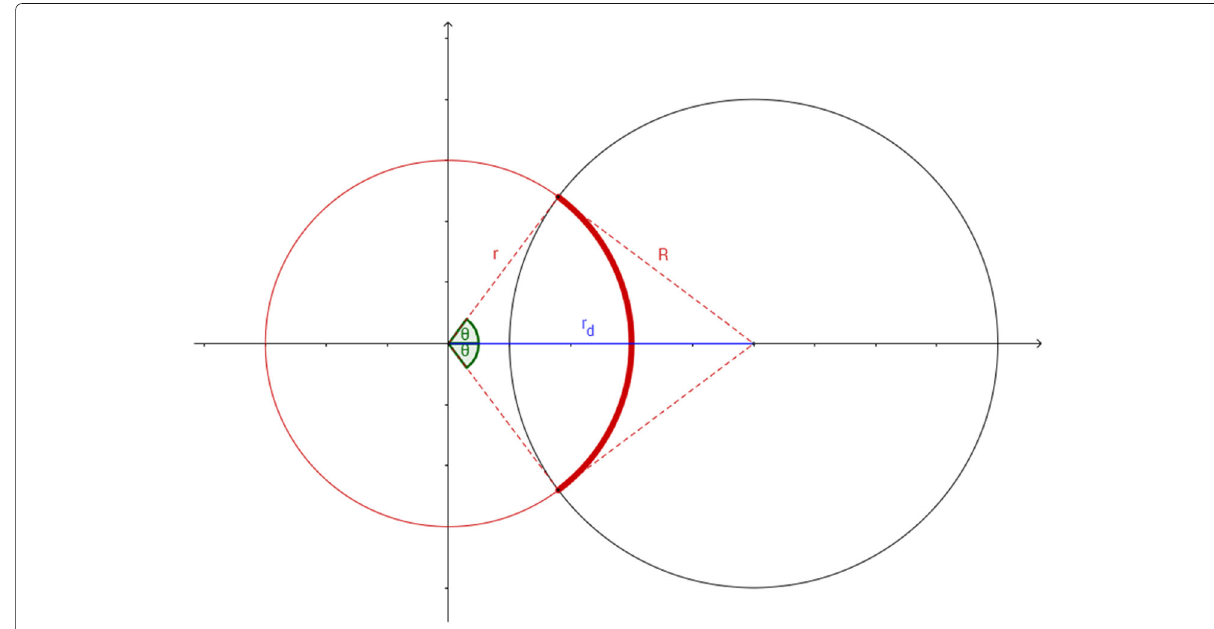
Fig. 17 Integration over a distinct